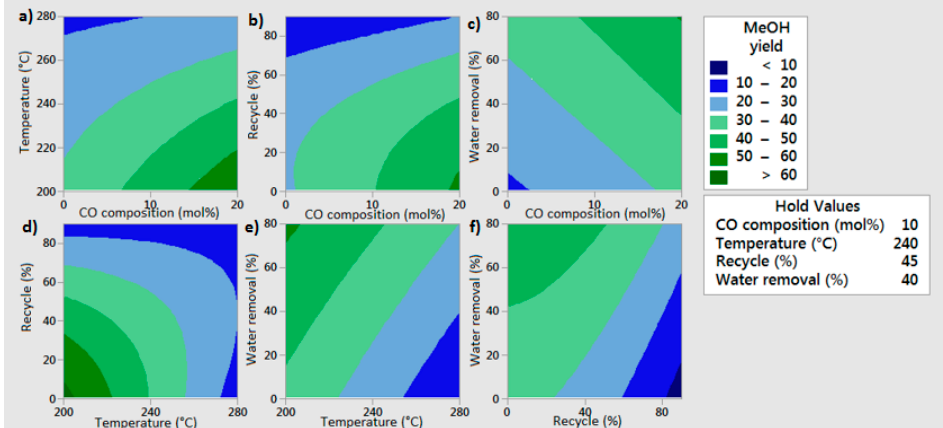
Figure 9. Surface plots of methanol yield obtained by CCD analysis: ( a ) methanol yield as function of temperature and CO composition in the feed; ( b ) methanol yield as function of recycle and CO composition in the feed; ( c ) methanol yield as function of water removal and CO composition in the feed; ( d ) methanol yield as function of recycle and temperature; ( e ) methanol yield as function of water removal and temperature; ( f ) methanol yield as function of water removal and